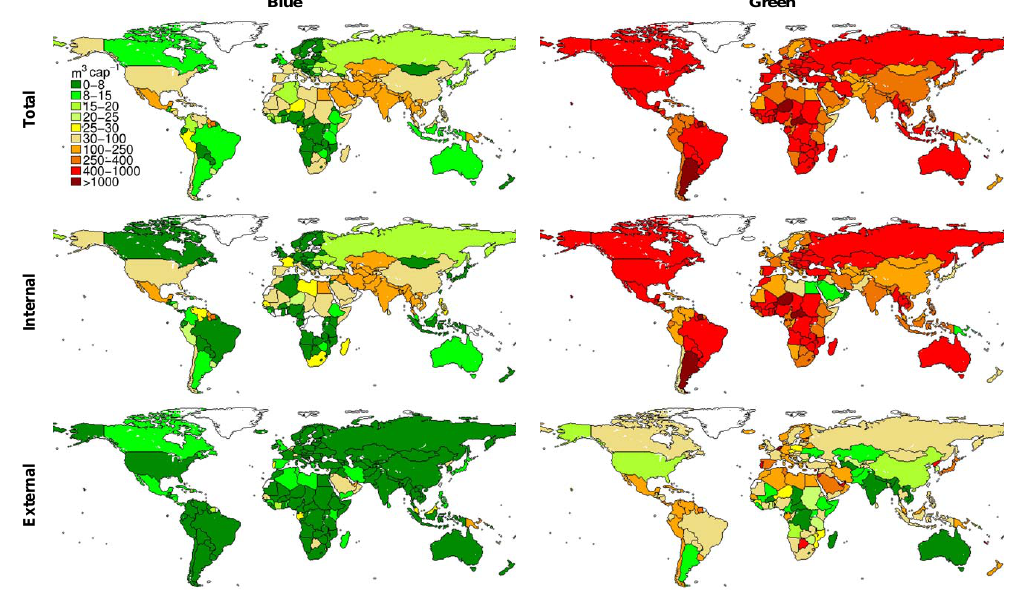
Fig. B1 . Fig. B1. External, internal and total blue and green water footprints per capita for all 11 CFTs, 1998–2002